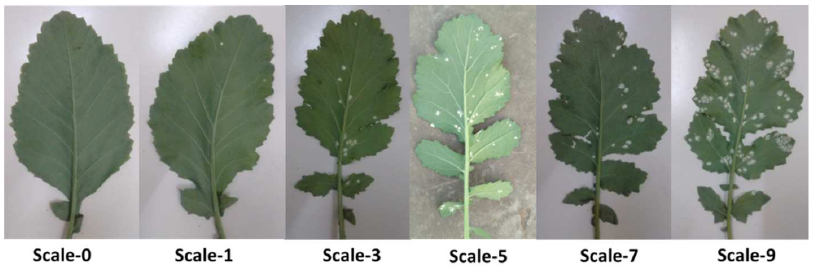
Figure 1. Photographic 0–9 scale of disease reaction for screening of genotypes at true leaf stage.